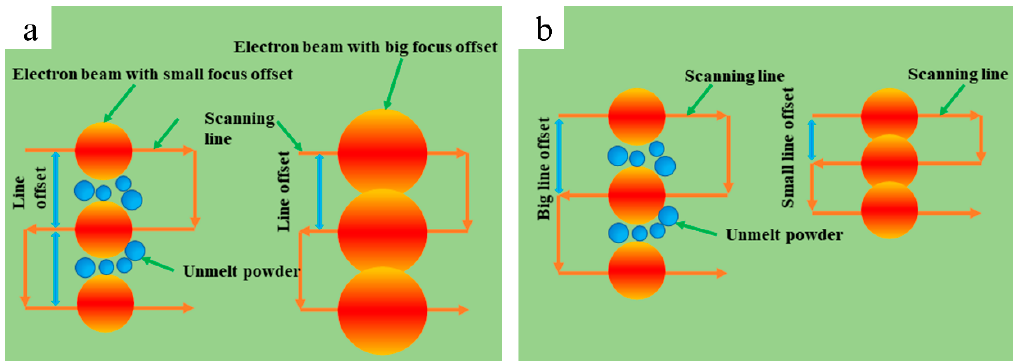
Figure 5. Schematic diagram of the relationship between line offset and electron beam spot: ( a ) line offset is the same but spot diameter is different; ( b ) spot diameter is the same but line offset is different.